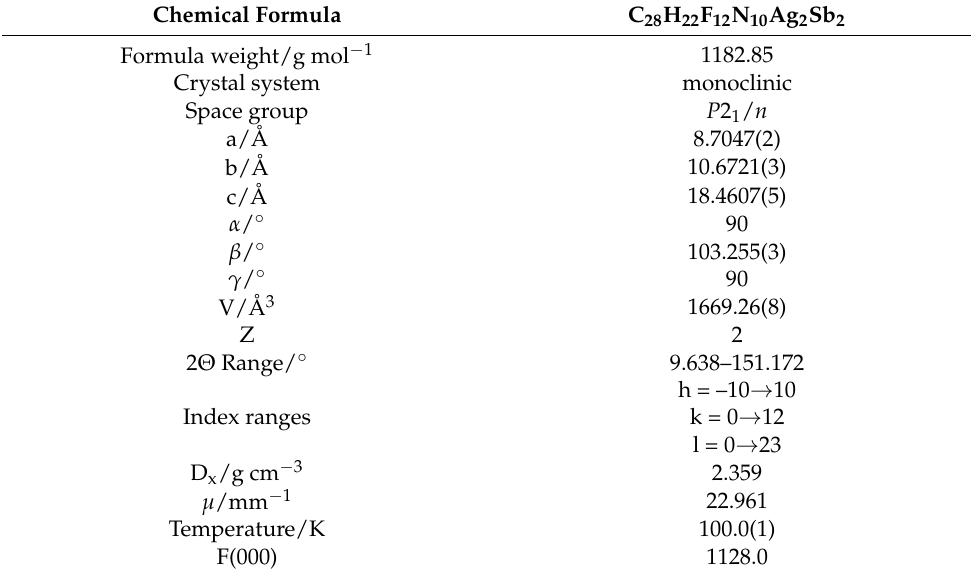
Figure 1. ( a ) ORTEP representation of the stoichiometric unit of [Ag 2 L 2 ](SbF 6 ) 2 (Ag1-N3 2.151(10); Ag1-N4 2.385(10); and Ag1-N5 2.217(10) Å). Atom numbering is given for the asymmetric unit and the displacement probability ellipsoids are shown at the 50% level, ( b ) Ag ··· Ag separations within one molecule and between adjacent molecules (H-atoms have been omitted for clarity). Table 1. Crystal and structure refinement data for [Ag 2 L 2 ](SbF 6 ) 2